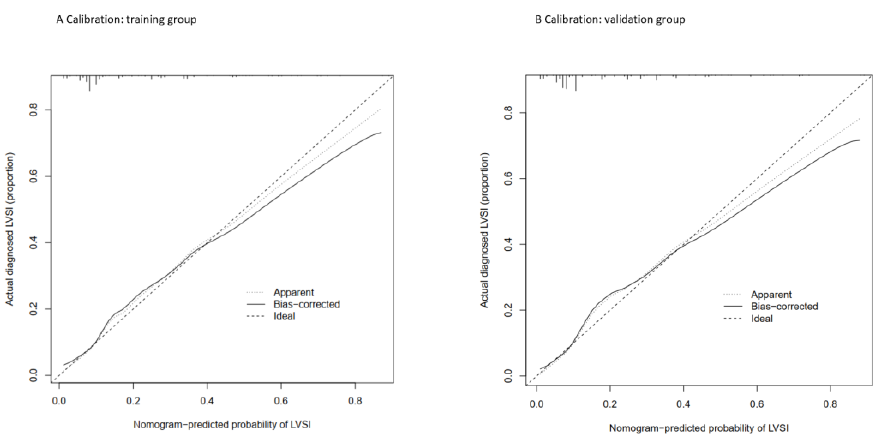
Figure 3. Calibration plots of the nomogram to predict LVSI in ( A ) training cohort and ( B ) validation cohort.